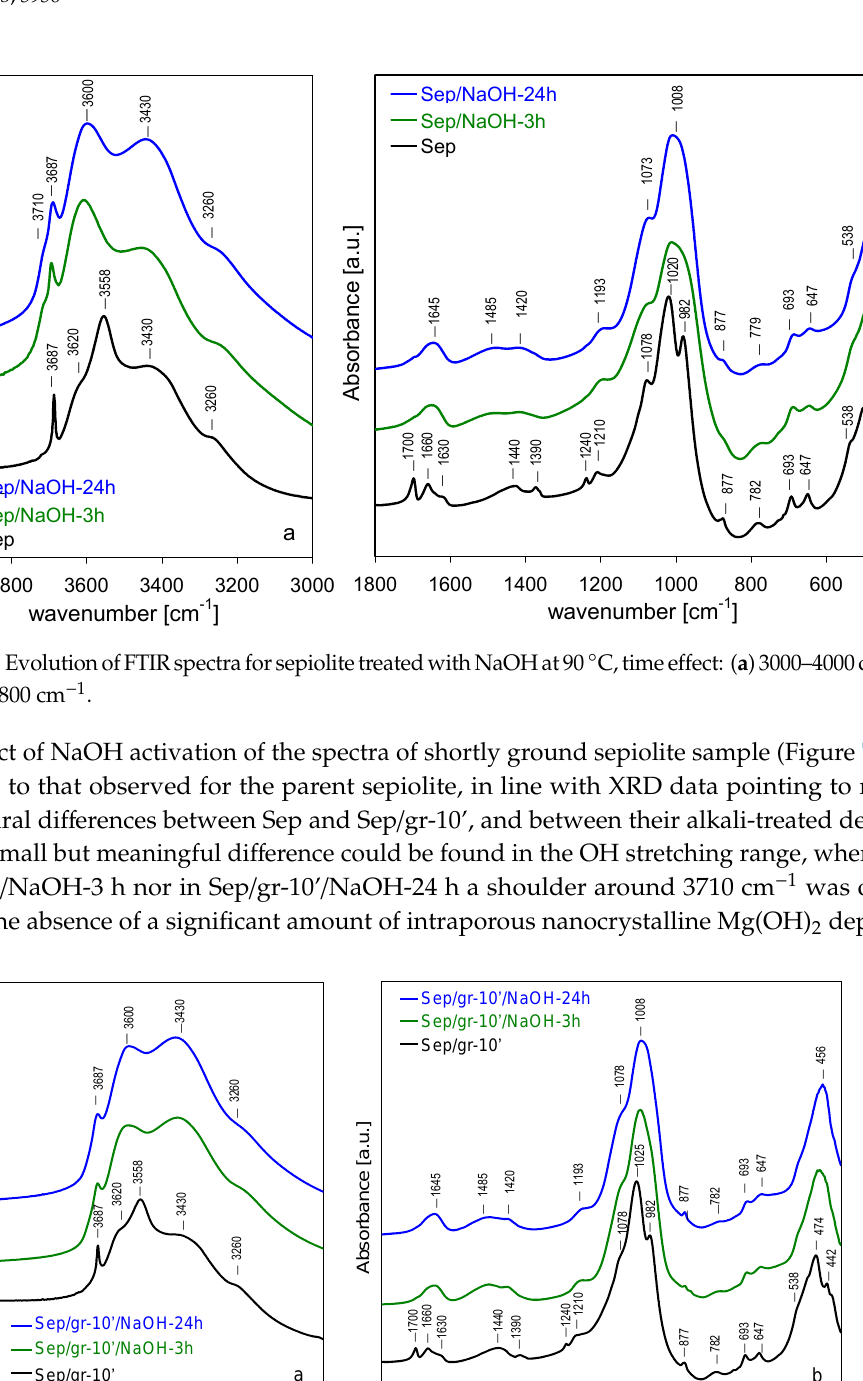
Figure 8. Evolution of FTIR spectra for sepiolite ground for 30 min and treated with NaOH at 90 °C, time effect: ( a ) 3000–4000 cm −1 , ( b ) 400–1800 cm −1 .